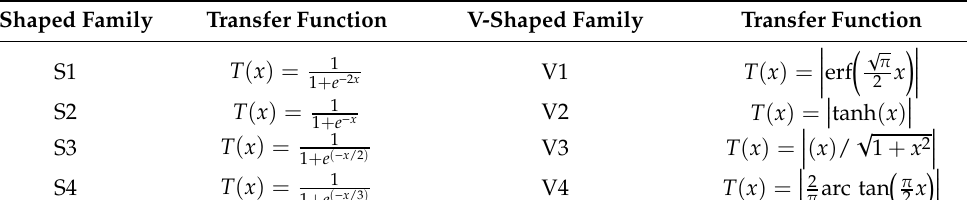
Table 1. The utilized S-shaped and V-shaped transfer functions.